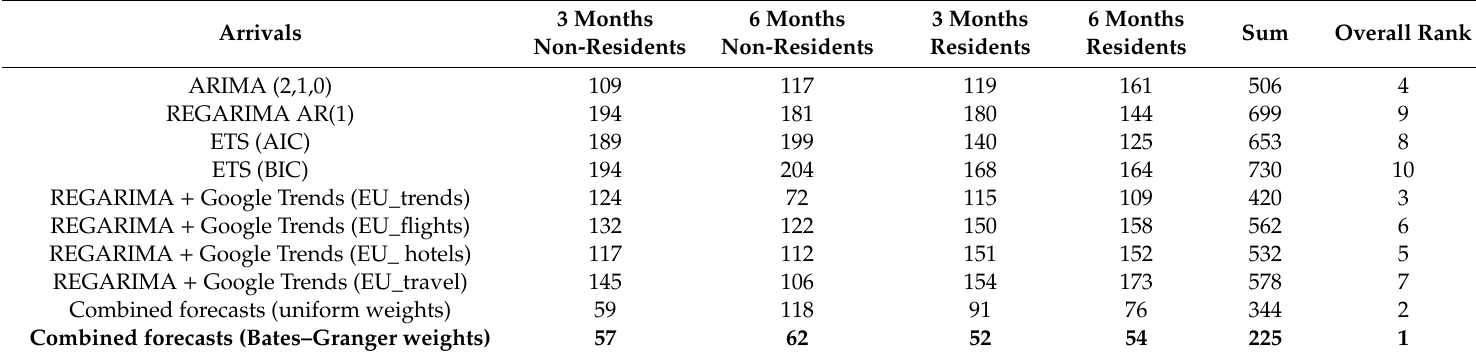
Table 1. Summary ranking of the overall results for arrivals forecasts. Source: European Commission (2017) and own calculations. Boldface indicates the single forecasting model(s) / forecast combination technique(s) characterized by the lowest sum of ranks.